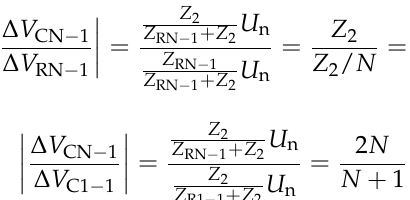
Figure 12. The overvoltages for different transformers when the number of running feeders changes: ( a ) amplitude; ( b ) steepness.